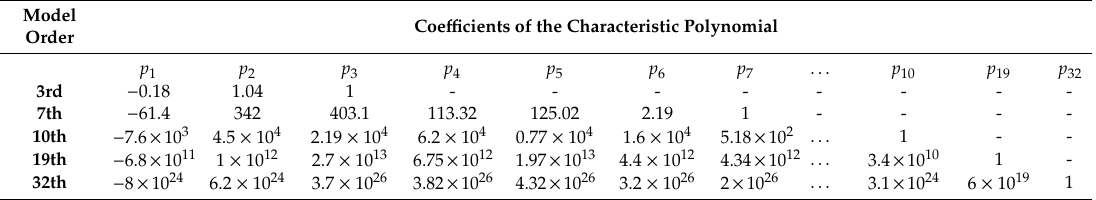
Coe ffi cients of the Characteristic Polynomial